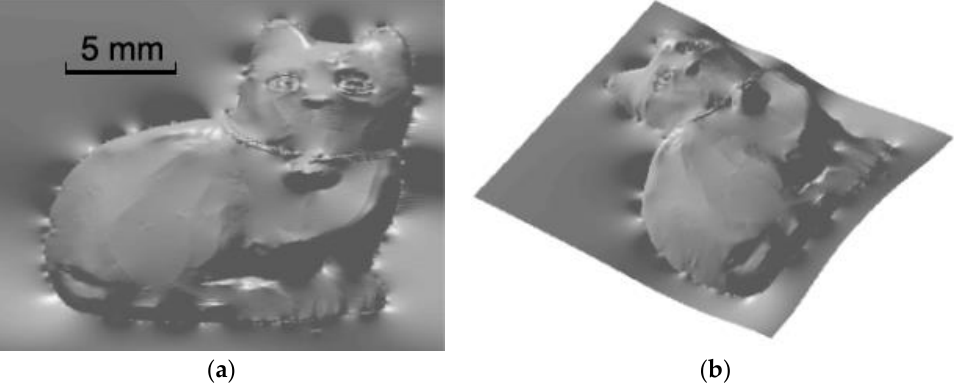
Figure 8. Reconstructed cat using the proposed method (two view angels): ( a ) top view, ( b ) rotated view.